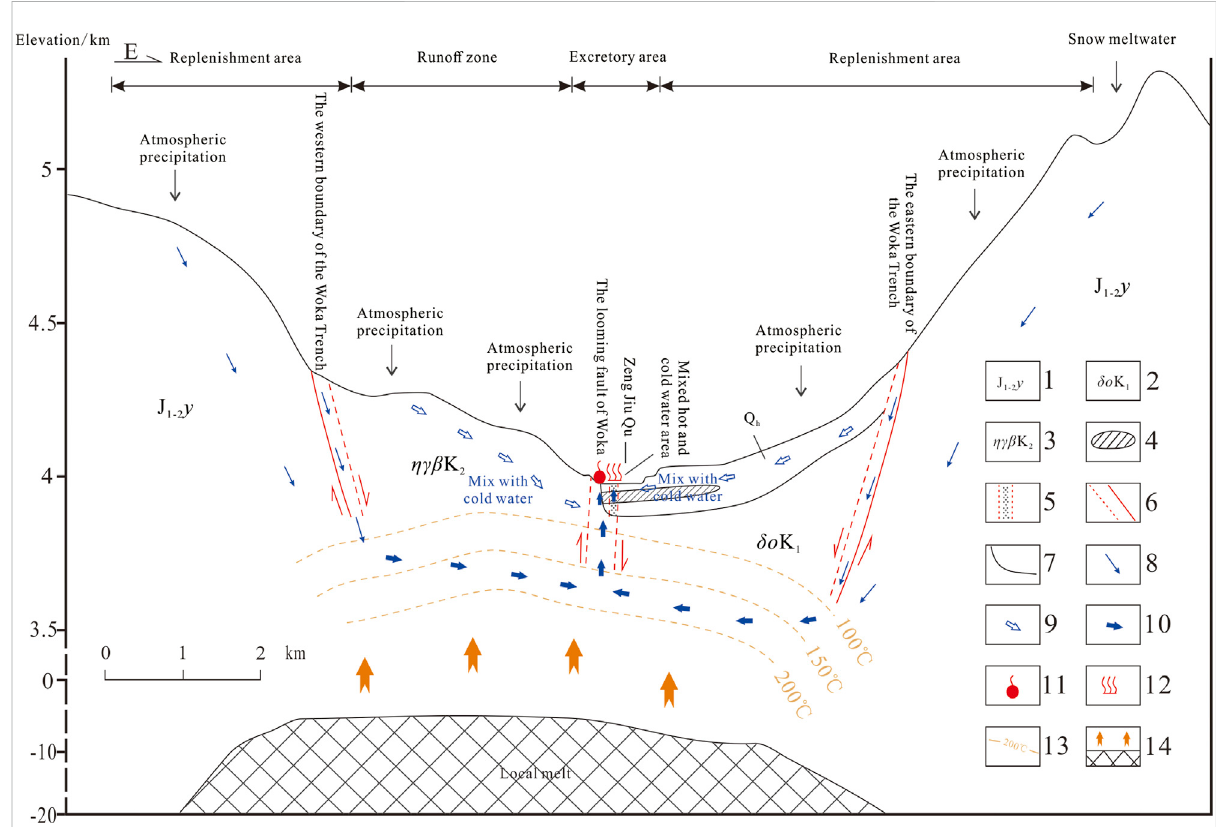
FIGURE 8 GeneticmodelofgeothermalwatersintheWokaGrabenbasin.1-MiddletoLowerJurassicYebaformation;2-LowerCretaceousquartzdiorite; 3-Middle Cretaceous monzogranite;4-Tight sand cover; 5-Channel of Quaternary thermal reservoir; 6-Measured or inferred fault; 7-Geological boundary; 8-Cold water and transport direction; 9-Mixed cold water and its migration direction; 10-Geothermal water and fl ow direction; 11- Geothermal spring; 12-Warm water swamp; 13-Inferred temperature contour; 14-Heat